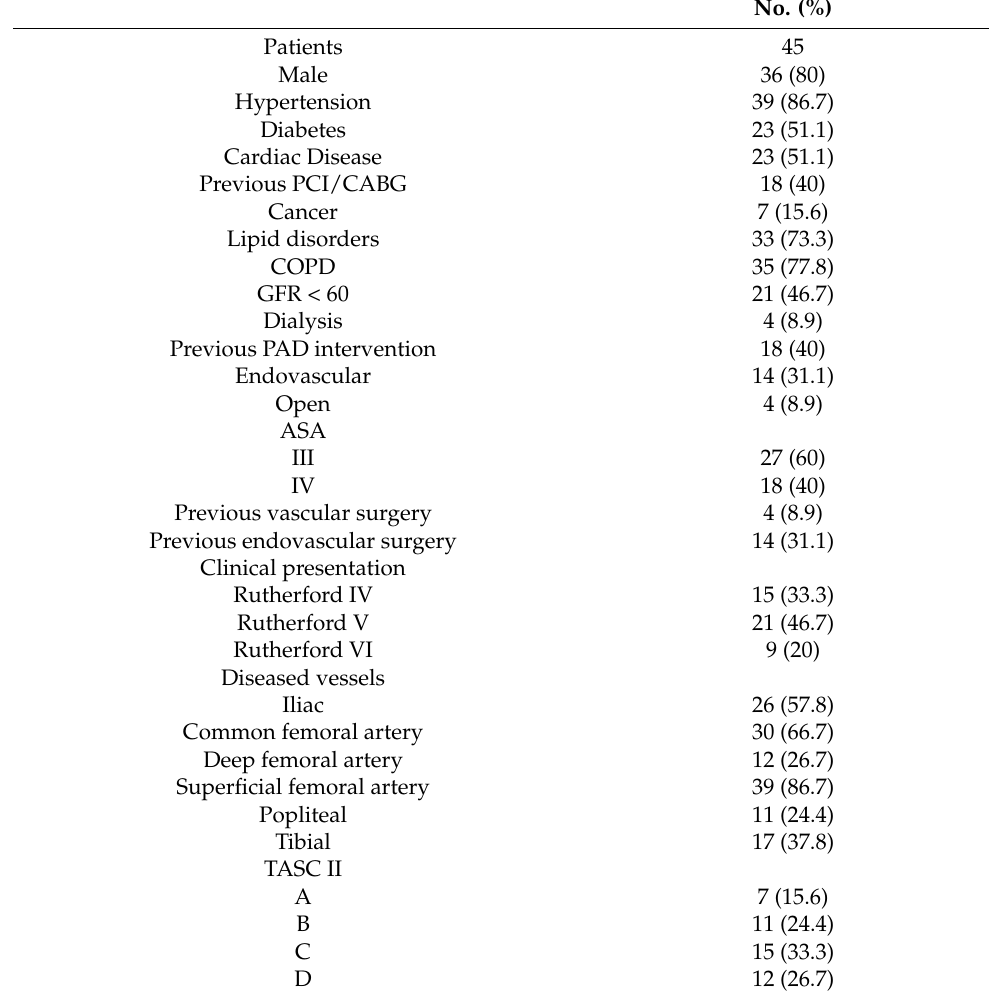
Table 1. Comorbidities and preoperative